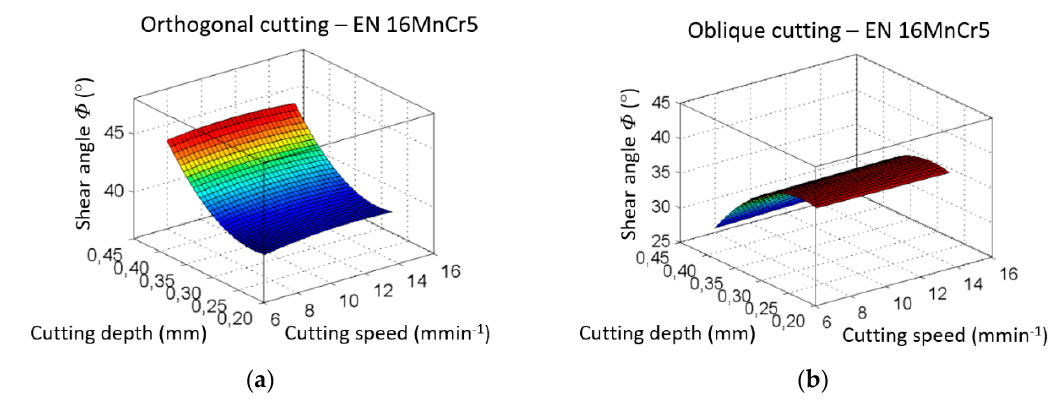
Figure 20. Dependence of shear angle Φ on cutting speed v c and cutting depth a p ; ( a ) orthogonal cutting; ( b ) oblique cutting.